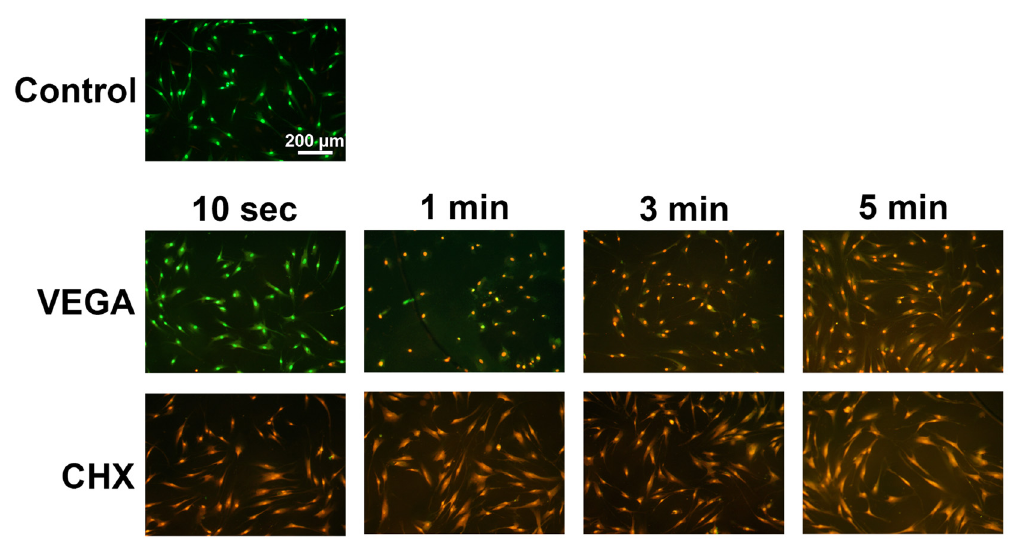
Figure 1. Cell viability of human gingival fibroblasts (HGF-1 cells) exposed to 100% of antiseptic oral rinses (either VEGA or CHX) for 10 sec, 1 min, 3 min, or 5 min, respectively. Live–dead staining was done with viable cell appearing in green and red cells stained with PI representing dead cells. VEGA showed viable cells at 10 sec and 1 min treatments, whereas cells cultured with CHX demonstrated dead cells in as little as 10 sec.